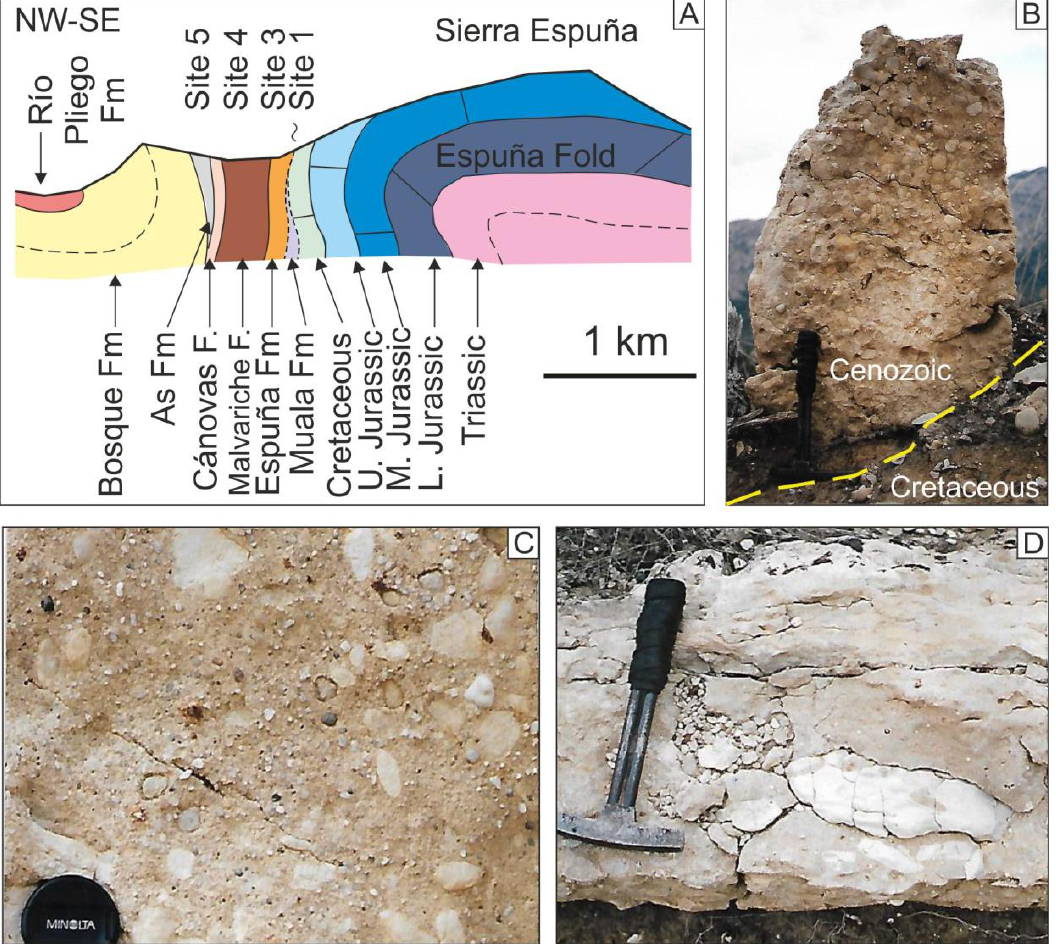
Figure 5. Site 1: Cretaceous-Cenozoic boundary from the Cenozoic Malaguide Basin from Sierra Espuña. ( A ) Geological cross-section in the Malvariche Valley of the Cretaceous-Cenozoic boundary. ( B ) Conglomerate with marly limestone and quartzite pebbles in the Cretaceous-Cenozoic boundary. ( C ) Detail of the conglomerate with marly limestone and quartzite pebbles in the Cretaceous-Cenozoic boundary. ( D ) Detail of Cretaceous marly limestone